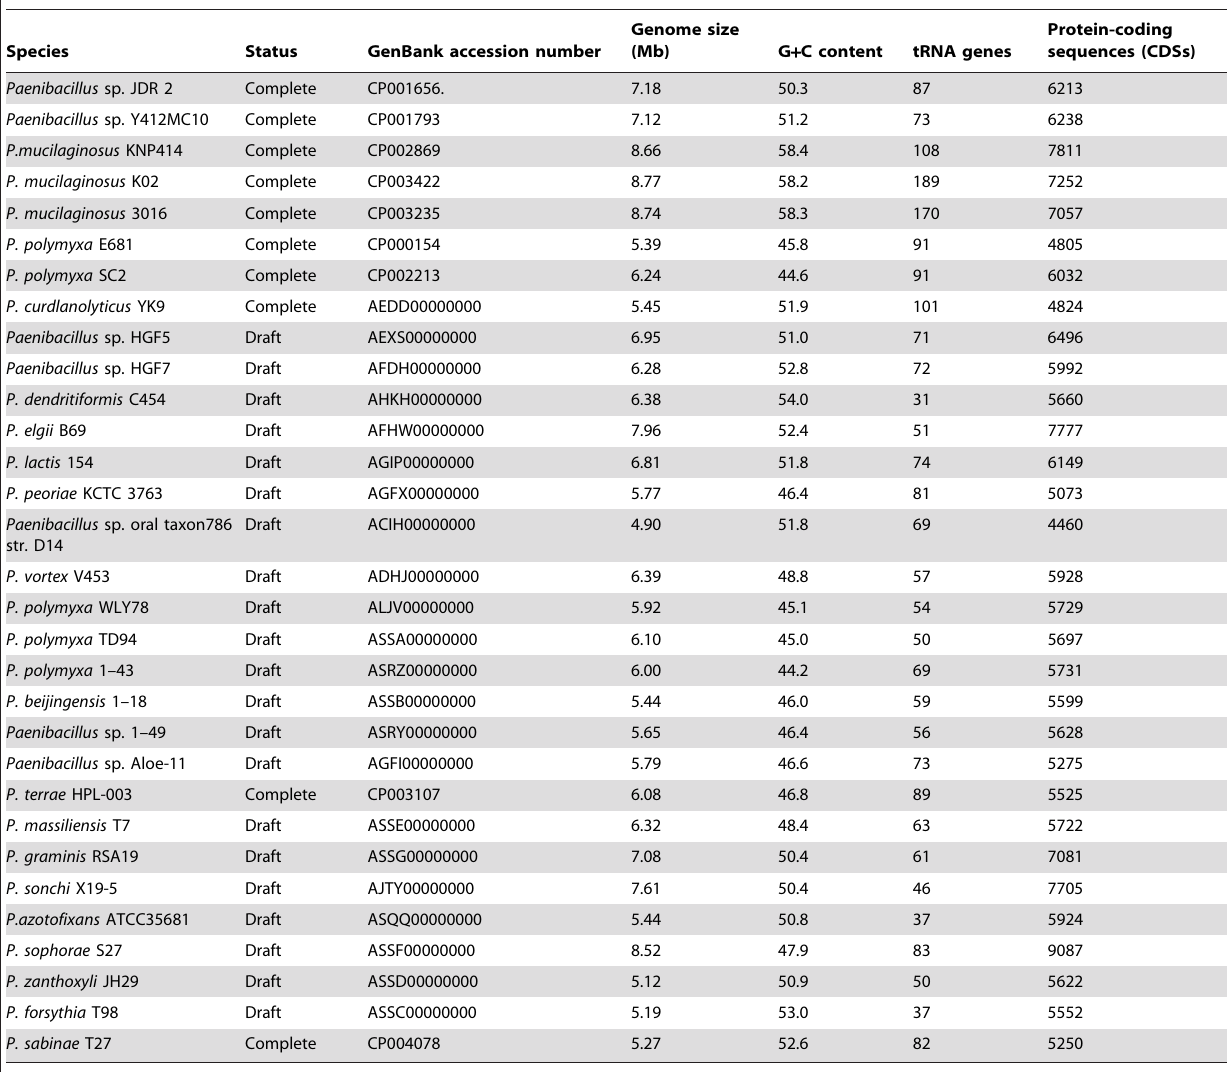
Table 2. Genomic features of Paenibacillus